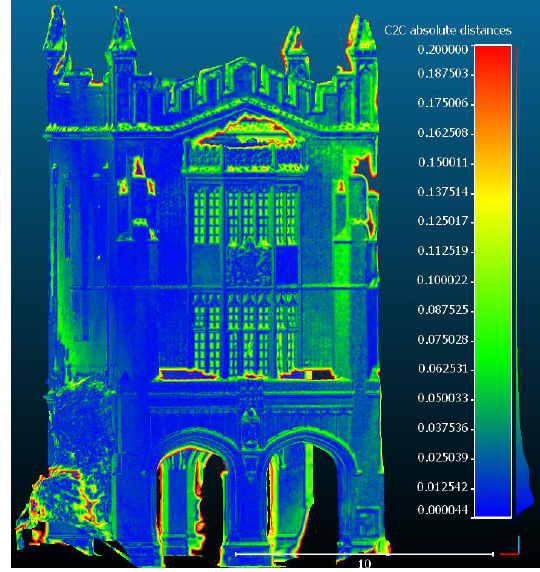
Figure 10. Comparison of image-based 3D modelling point cloud (top left) with laser scanned point cloud (top right). Data were registered manually and compared using CloudCompare 5